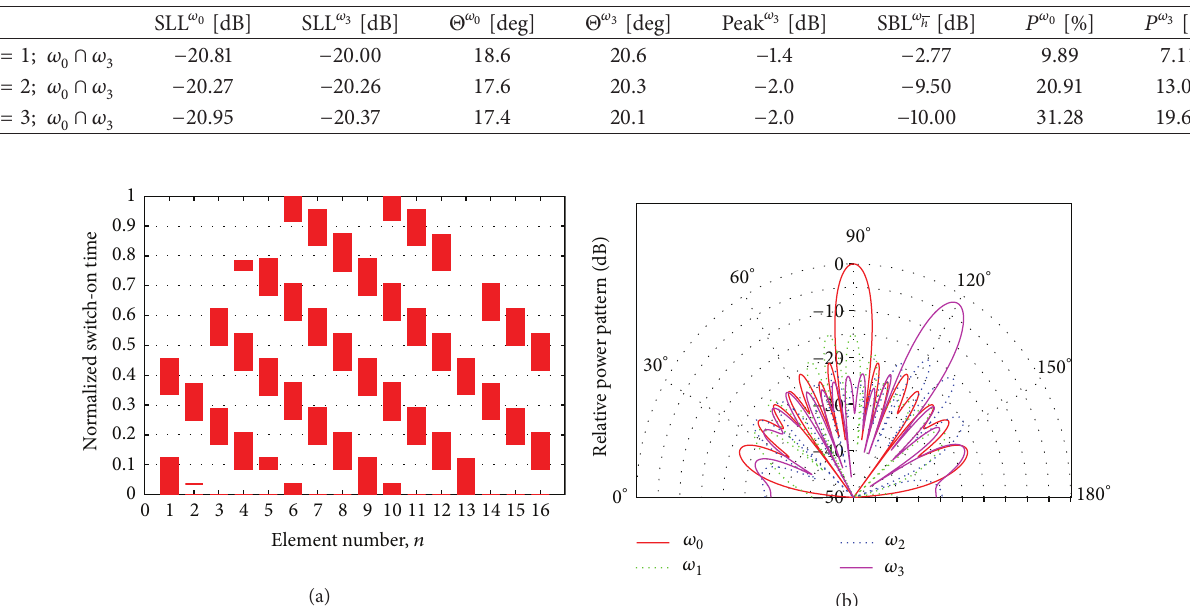
Figure 6: Multipulse waveform, 𝑄 = 3 —multibeam sum pattern synthesis at 𝜔 0 and 𝜔 3 ( 𝑁 = 16 ; 𝑑 = 𝜆/2 ; 𝜃 𝜔 0 = 90 ∘ ; 𝜃 𝜔 3 = 120 ∘ )—plot of (a) the optimized pulse sequence and (b) corresponding power patterns generated at 𝜔 0 , 𝜔 1 , 𝜔 2 , and 𝜔 3 .